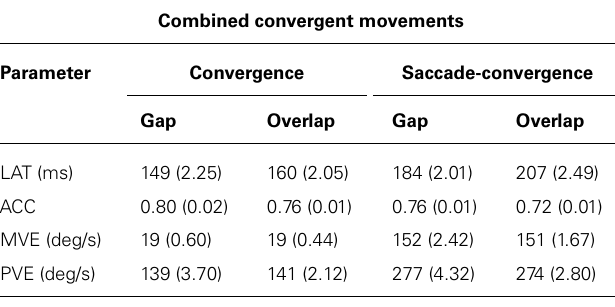
Table 2 | Mean values (with standard errors) listed per component (convergence, saccade-convergence, divergence and saccade-divergence) and task (gap and overlap) for each parameter (LAT, latency;ACC, accuracy; MVE, mean velocity; PVE, peak